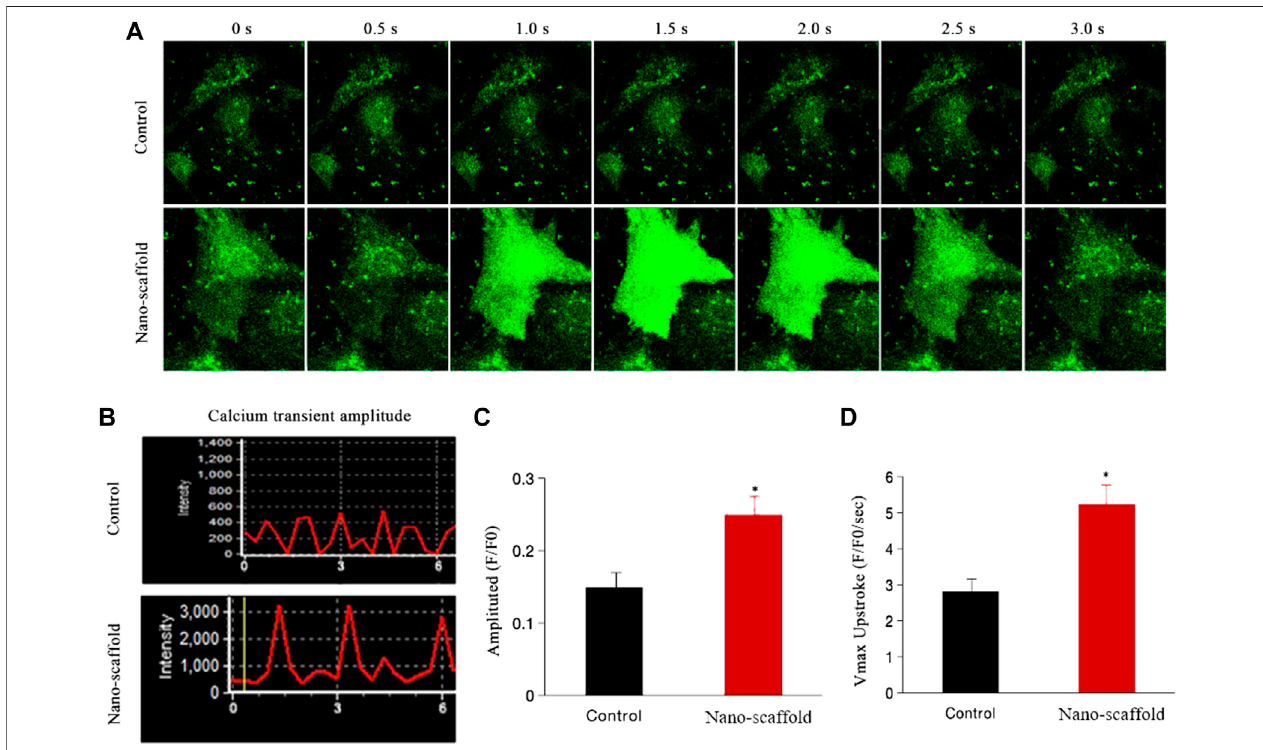
FIGURE 5 | Calcium transient was assessed in iPSC-CMs cultured on nano fi brous scaffold. (A) Representative line-scan of time-lapse calcium imaging in iPSC- CMs loaded with the intracellular calcium indicator Fluo-4 AM. (B) Representative records of spontaneous calcium transient. (C) Comparison of calcium transient peak amplitude between two groups. (D) Comparison of Vmax (F/F0/s) between two groups. Data are presented as mean ± SEM, * p < 0.05 vs. control.